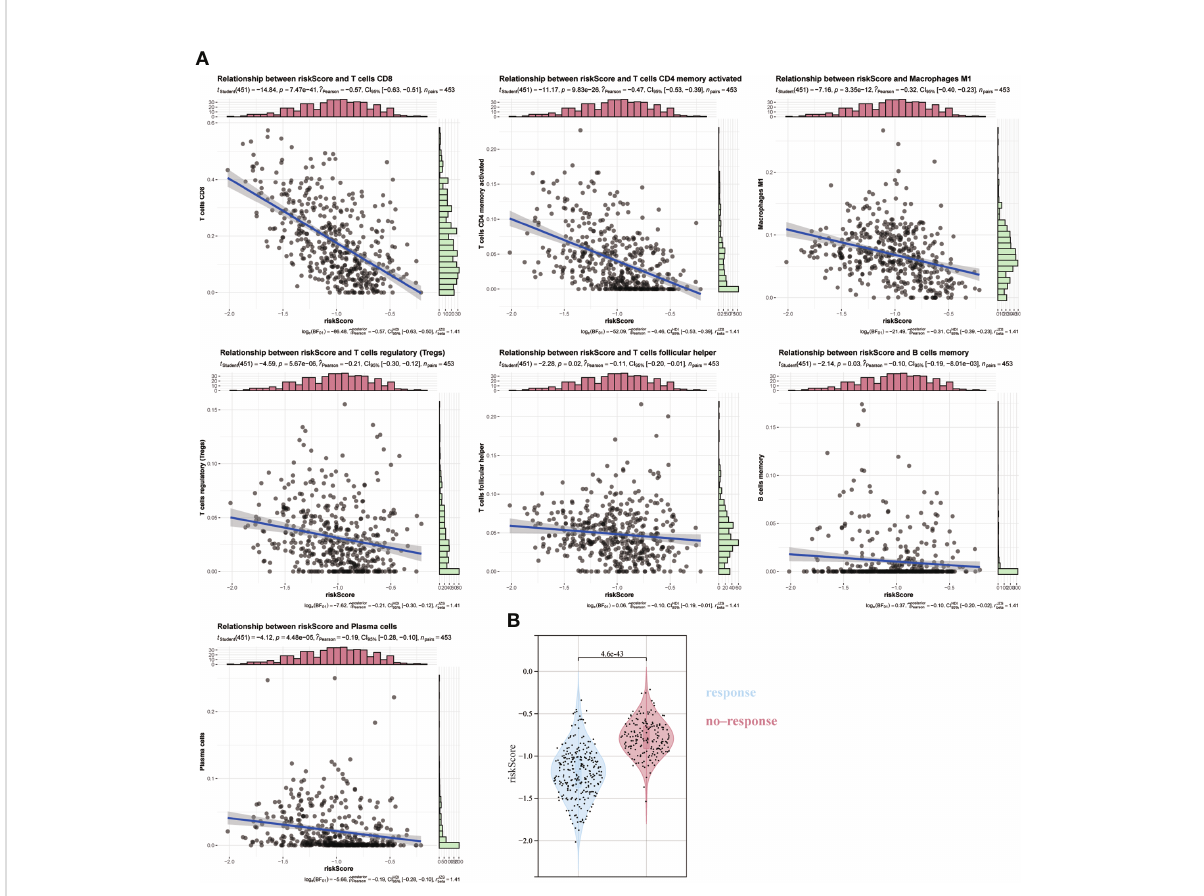
FIGURE 7 Association of ICD risk score with the tumor microenvironment. (A) Scatter plot showing the correlation of risk score with in fi ltration of CD8, activated NK cells and activated CD4 memory cells. (B) Plot showing the association of ICD risk score with response to